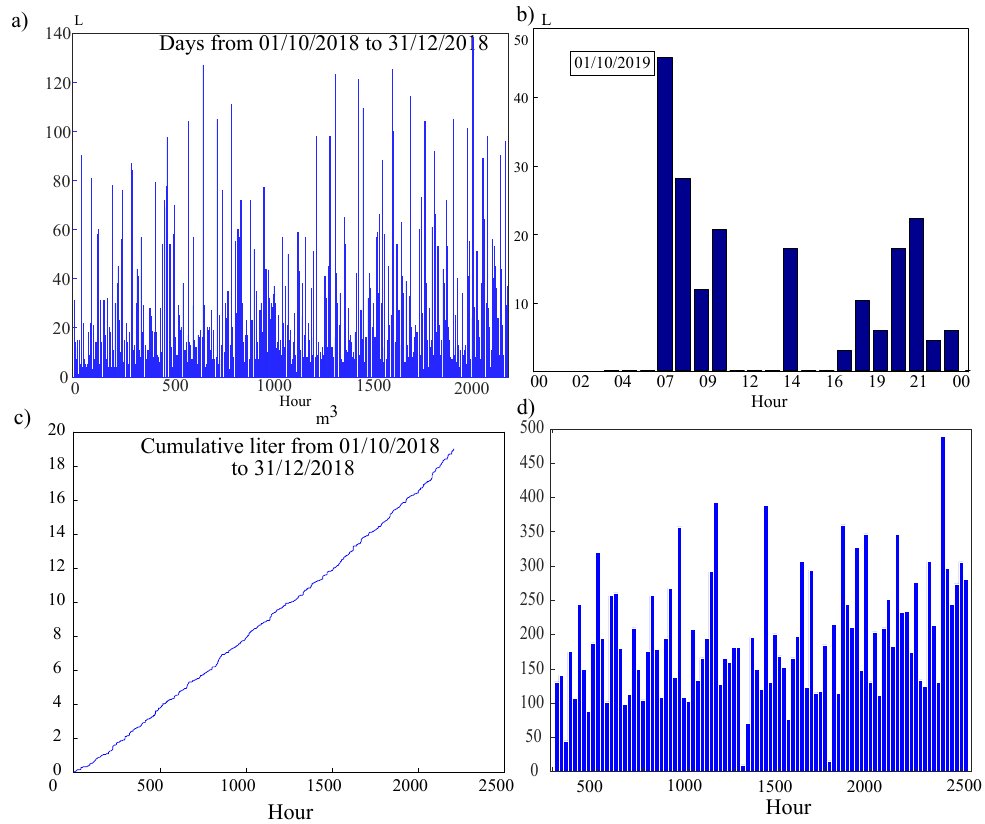
Figure 5. Water consumption time series: ( a ) LC from 1 October to 31 December 2018, ( b ) close-up view of the same time series for the first 24 h, ( c ) cumulative water LC over the whole period, ( d ) number of liters consumed per